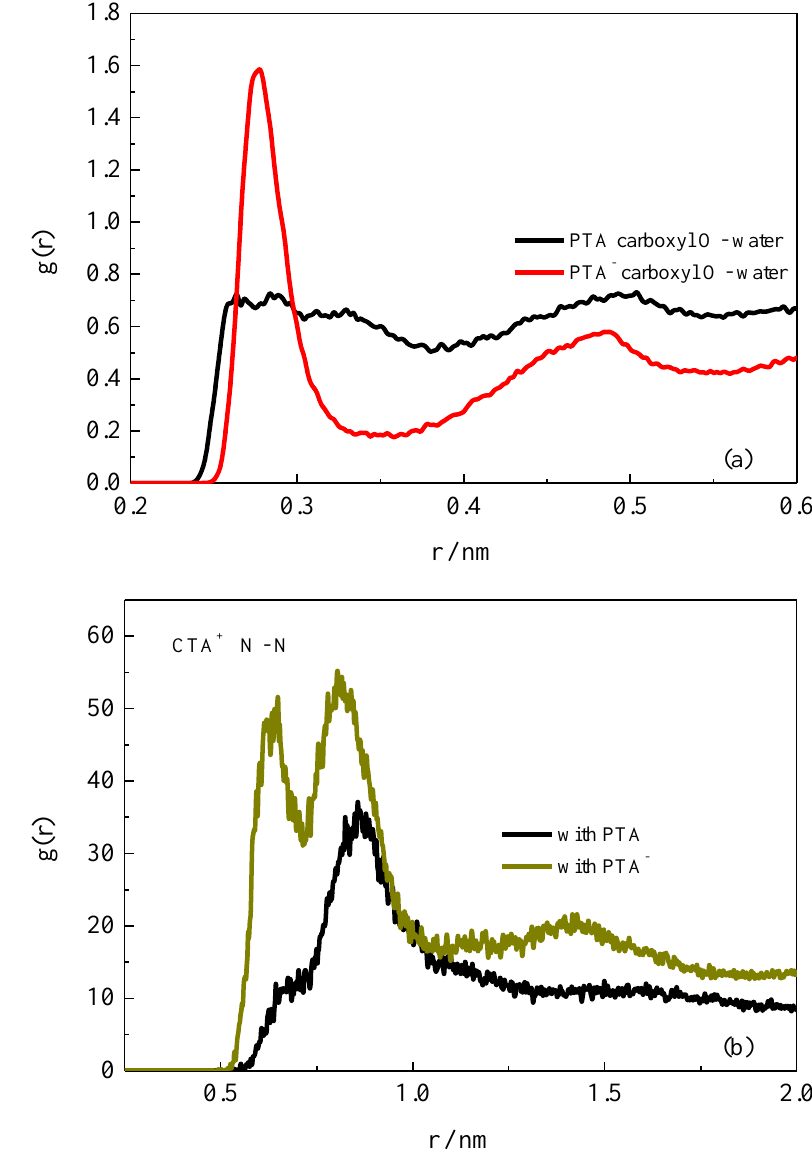
Figure 6. ( a ) RDFs between surfactant N atoms and water O atoms. ( b ) RDFs between surfactant N atoms.